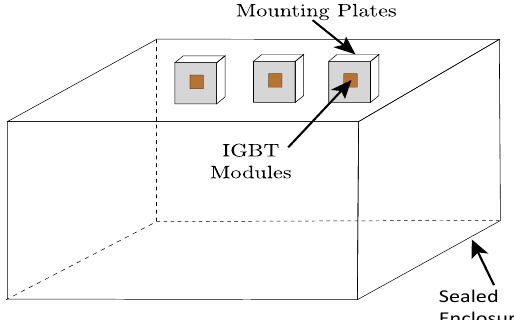
Figure 14. Three phase IGBT modules for generator side converter mounted on the inner walls of the submerged cabinet via a copper mounting plate. The copper mounting plate minimizes the spreading thermal resistance [5].